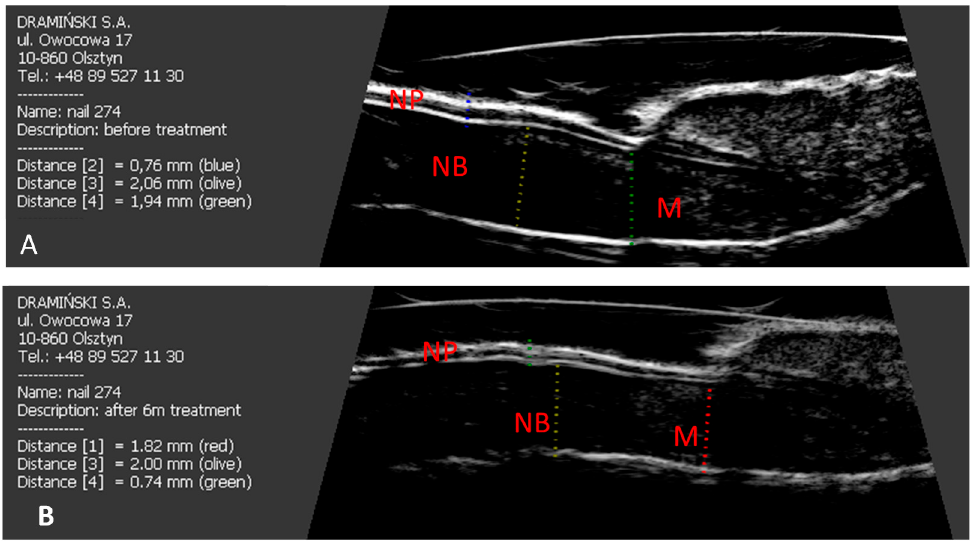
Figure 2. The effect of six months of acitretin treatment on the thickness of the nail plate, nail bed and nail matrix in patients studied. ( A ) longitudinal scan of psoriatic nail before treatment. ( B ) longitudinal scan of psoriatic nail after six months of acitretin treatment. NP: nail plate; NB: nail bed; M: nail matrix.